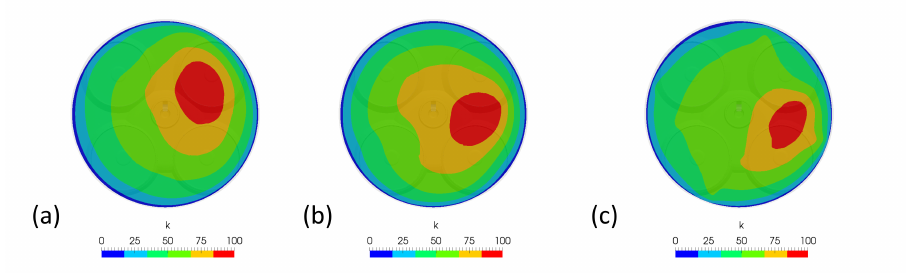
Figure 9. Kinetic energy distribution of turbulence on a plane orthogonal to the cylinder axis placed 5 mm below the cylinder head flow for the original ( a ), star ( b ), and tower ( c ) piston